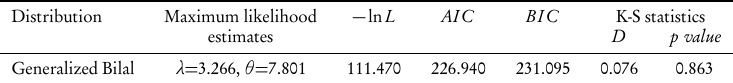
Summary fit to the real data set